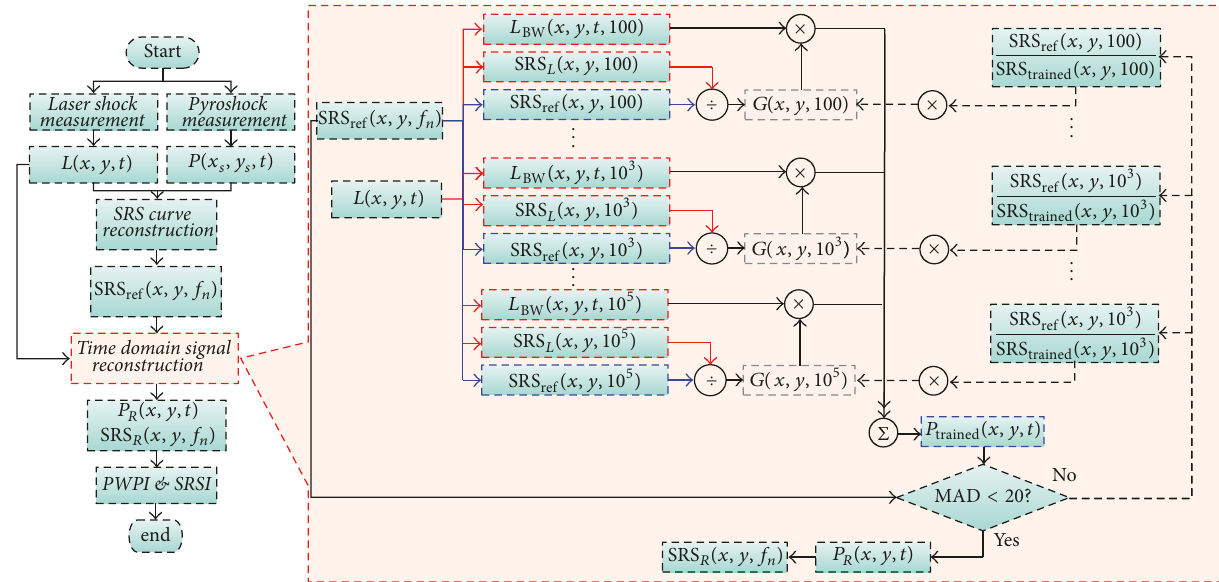
Figure 7: Reconstruction algorithm of pyroshock time domain